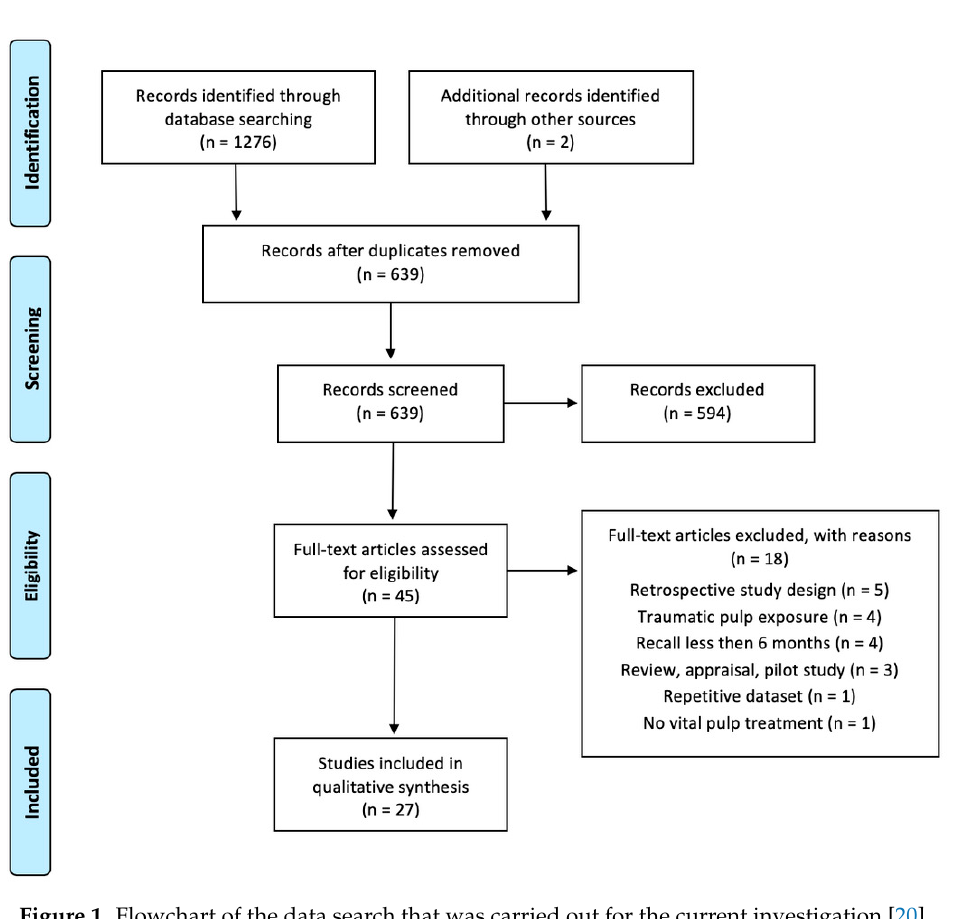
Figure 1. Flowchart of the data search that was carried out for the current investigation [20].